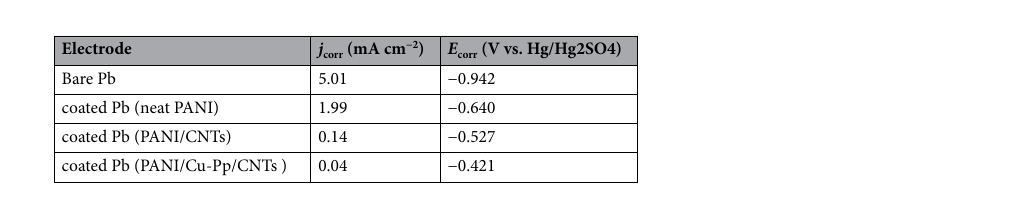
Table 2. The Tafel elements of bare and coated Pb electrodes.